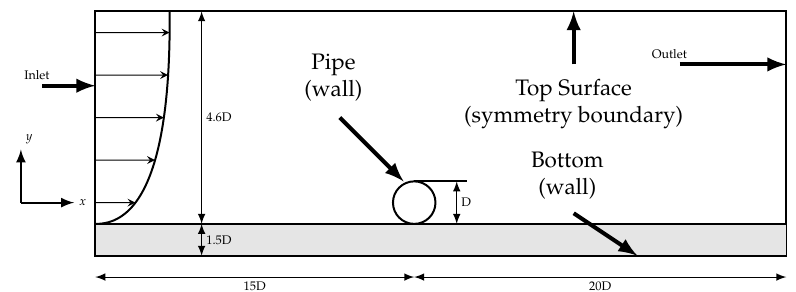
Figure 1. Sketch of the geometry and the boundary conditions used for the computational